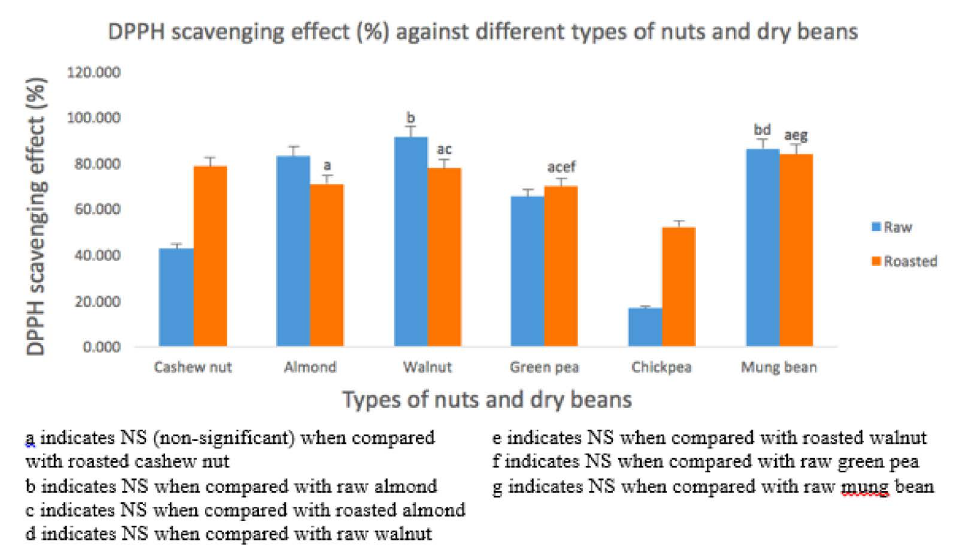
Fig. 1. DPPH scavenging effect (%) in raw and roasted dry beans and nuts